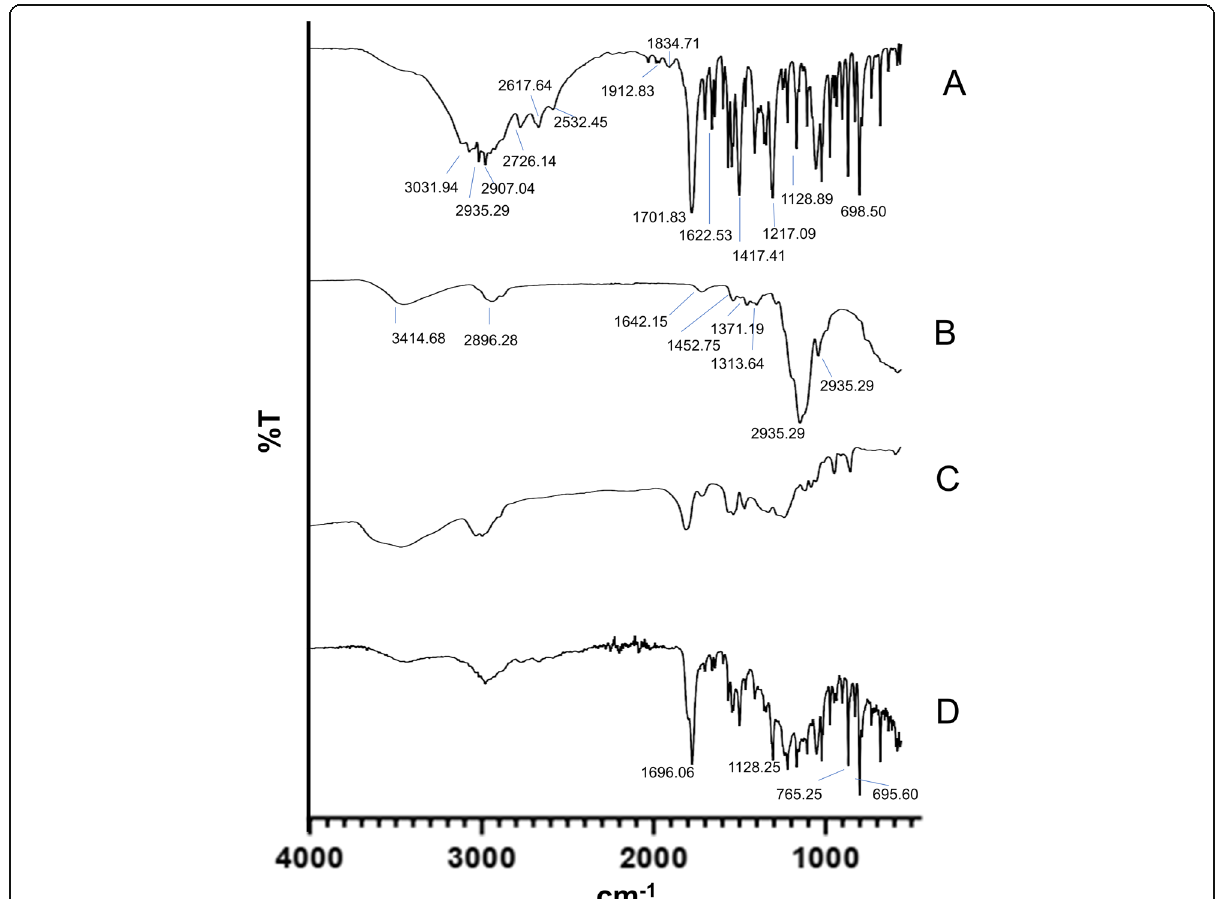
Fig. 1 FT-IR spectra of ( a ) pure flurbiprofen, ( b ) HPMC K15M, ( c ) ERL100 and ( d ) drug and polymer physical